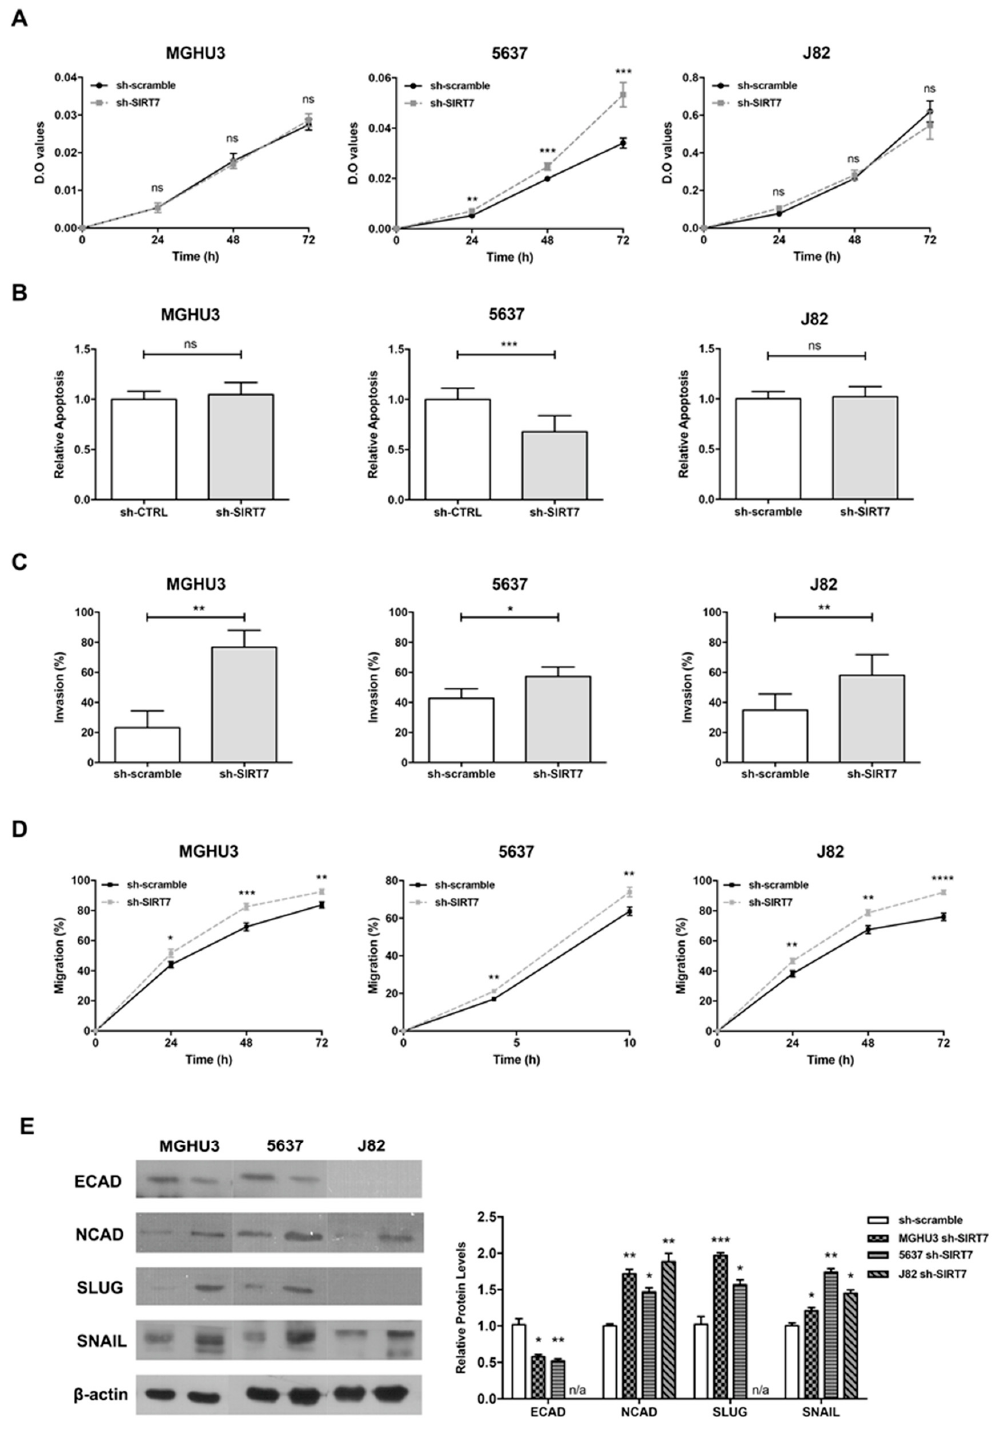
Figure 4. SIRT7 downregulation promotes invasiveness and EMT in bladder cancer cells. Effect of SIRT7 knockdown for MGHU3, 5637 and J82 cell lines at ( A ) cell viability by MTT assay, ( B ) apoptosis- cell death by APOPercentage assay, ( C ) cell invasion by BD Biocoat Matrigel Invasion Chambers and ( D ) cell migration by wound-healing assay; * p < 0.05, ** p < 0.01, *** p < 0.001 and **** p < 0.001; results are representative of three independent experiments with mean ± SD, each of them in triplicates. Expression of epithelial and mesenchymal markers and EMT transcription factors ( E ) in MGHU3, 5637 and J82 SIRT7 knockdown by western blot; results are representative of three independent experiments with mean ± SD.